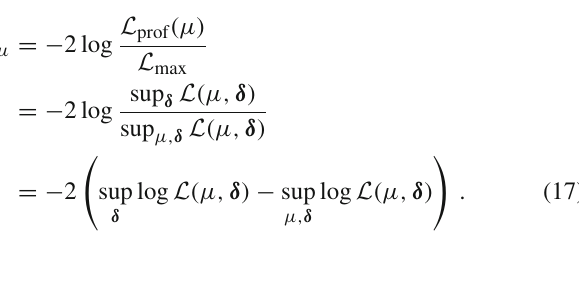
Fig. 5 Distribution of log L values in S 1 , S 2 and S 3 . S 1 represents the unbiased sampling,